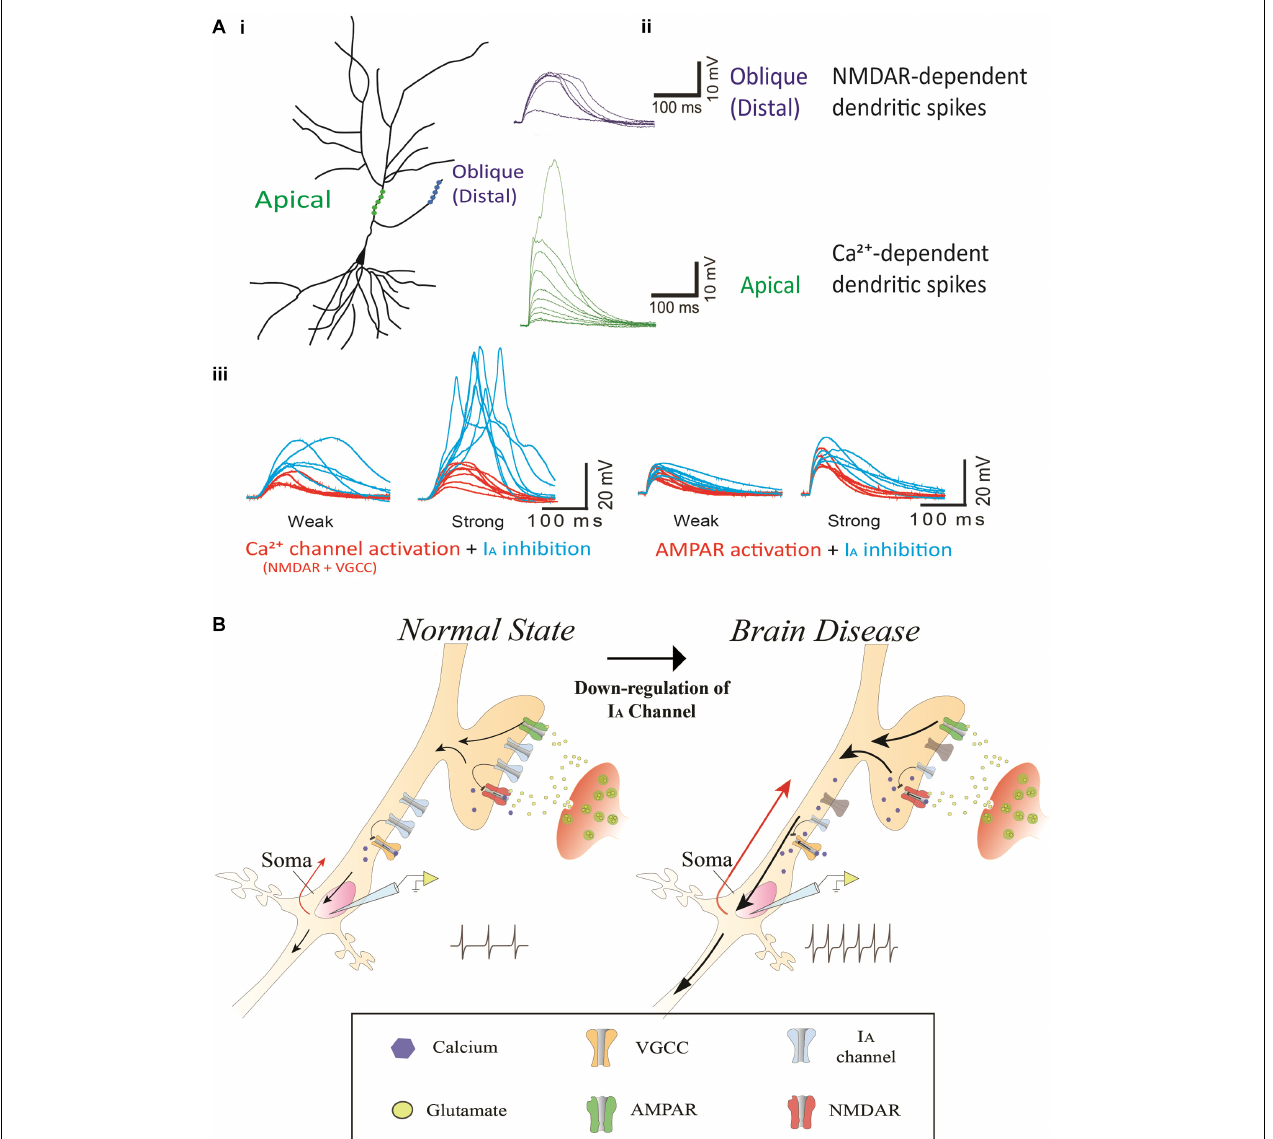
FIGURE 2 | The contribution of I A channels on neuron excitability and brain disease. (Ai) A schematic of two photoactivated locations (distal and apical trunk) of a hippocampal neuron. (Aii) Examplar gluEPSPs (or glutamate-evoked EPSPs) in response to photoactivation in the distal and apical trunk. Note that there is a sudden increase in the response, being referred to as a NMDA-dependent dendritic spike and Ca 2 + -dependent dendritic spike in the distal and apical trunk, respectively. (Aiii) The blockage of 4-AP (3 mM) sensitive-I A channels potentiates the responses of NMDARs but not AMPARs. The left traces illustrate NMDAR (and VGCC)-mediated EPSPs, respectively, in a thin oblique dendrite or in an apical dendrite over an input strength; weak (averaged 6.3 µ J ) and strong (averaged 11.2 µ J ) energy. The right traces illustrate AMPAR-mediated EPSPs in a thin oblique dendrite over an input strength; weak (averaged 2.4 µ J ) and strong